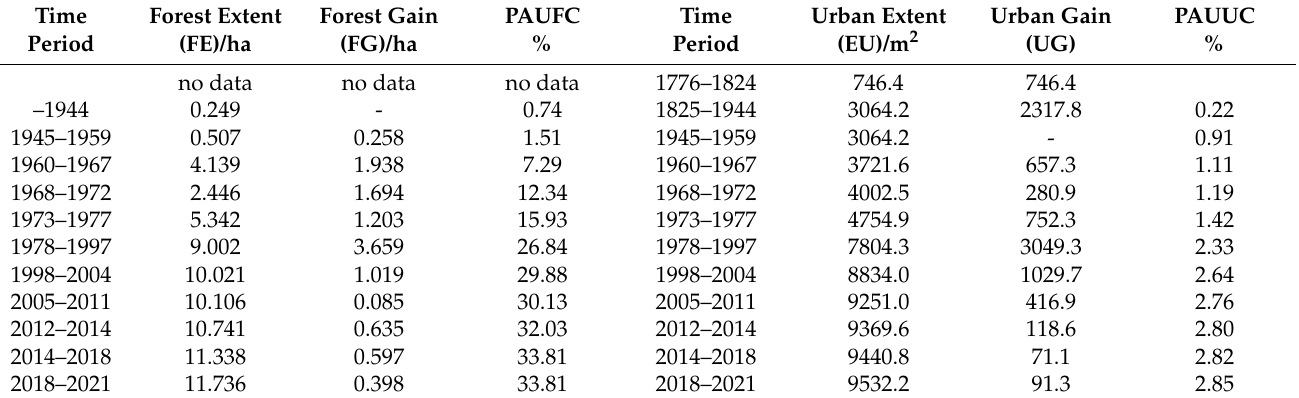
Table 6. Six indicators (FE, FG, PAUFC, UE, UG, and PAUUC) for (1994–2021).